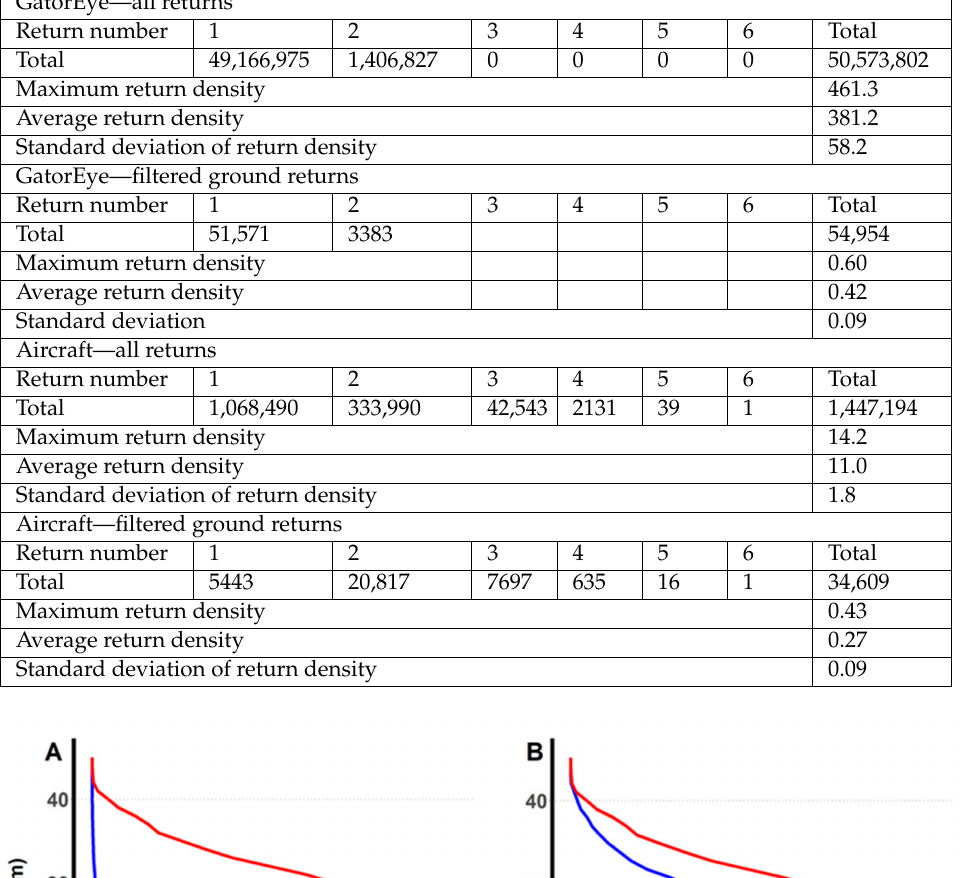
Table 4. Summary statistics for aircraft- and GatorEye-system-derived LiDAR point clouds extracted from the permanent sample plots.